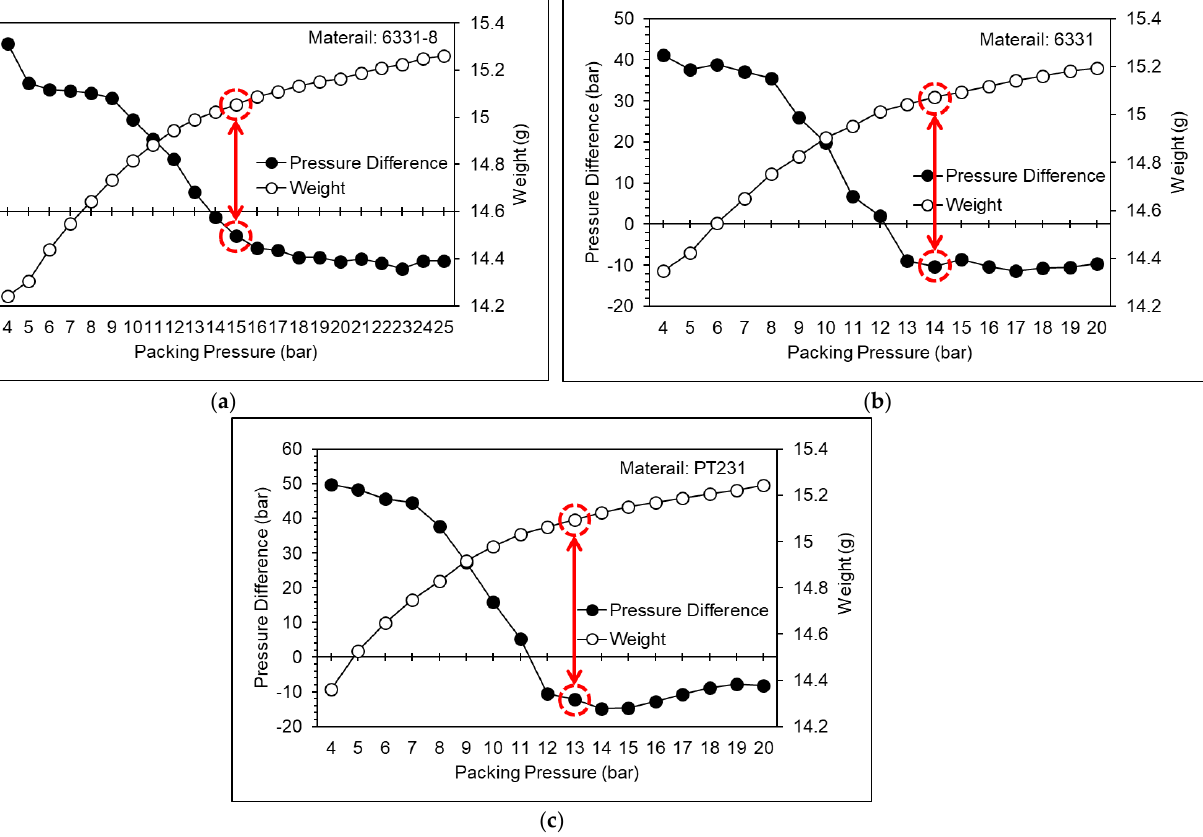
Figure 20. Pressure difference and product weight at different pressures (( a ) 6331 − 8, ( b ) 6331, and ( c ) PT231).